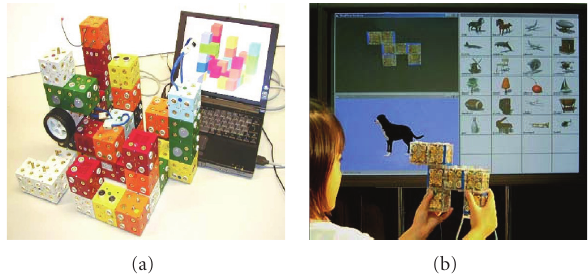
Figure 1: Appearance of the ActiveCube